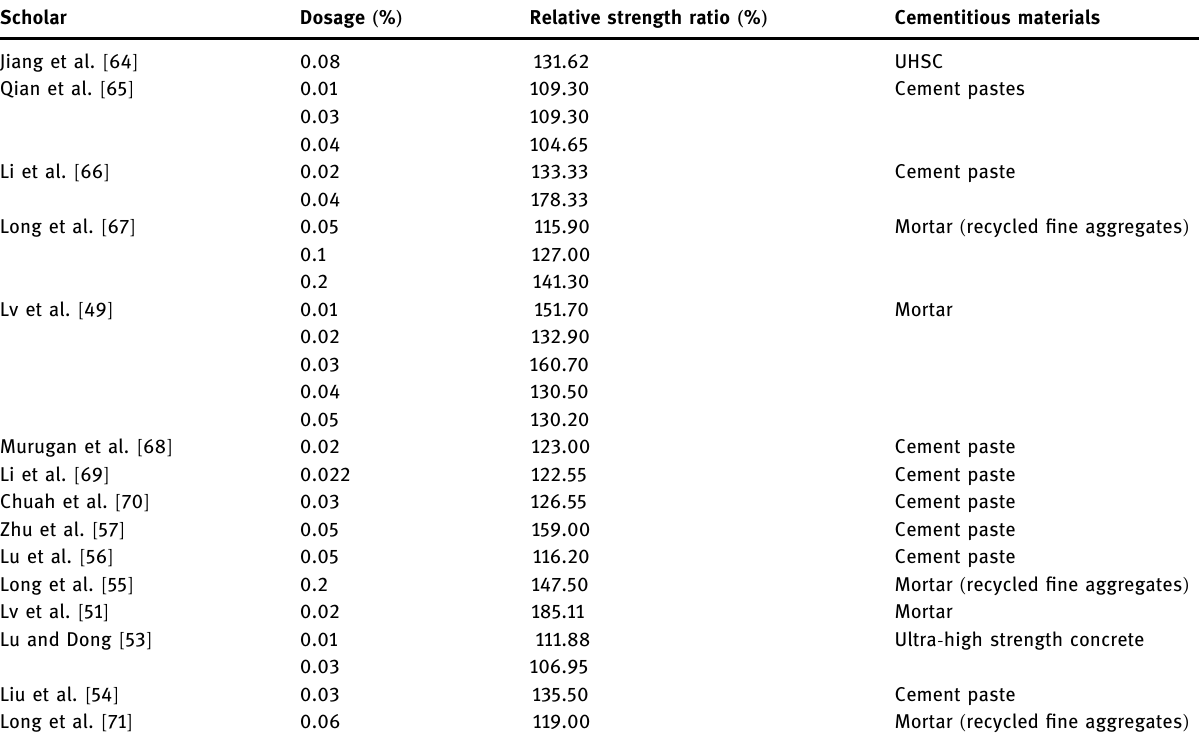
Table 3: Flexural strength of GO - modi fi ed cementitious materials Scholar Relative strength ratio ( % )